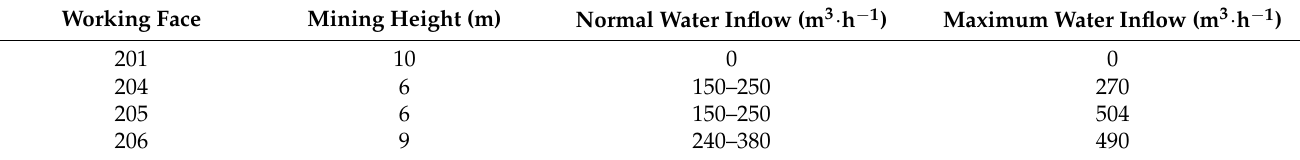
Table 1. Water inflow at the No. 2 panel